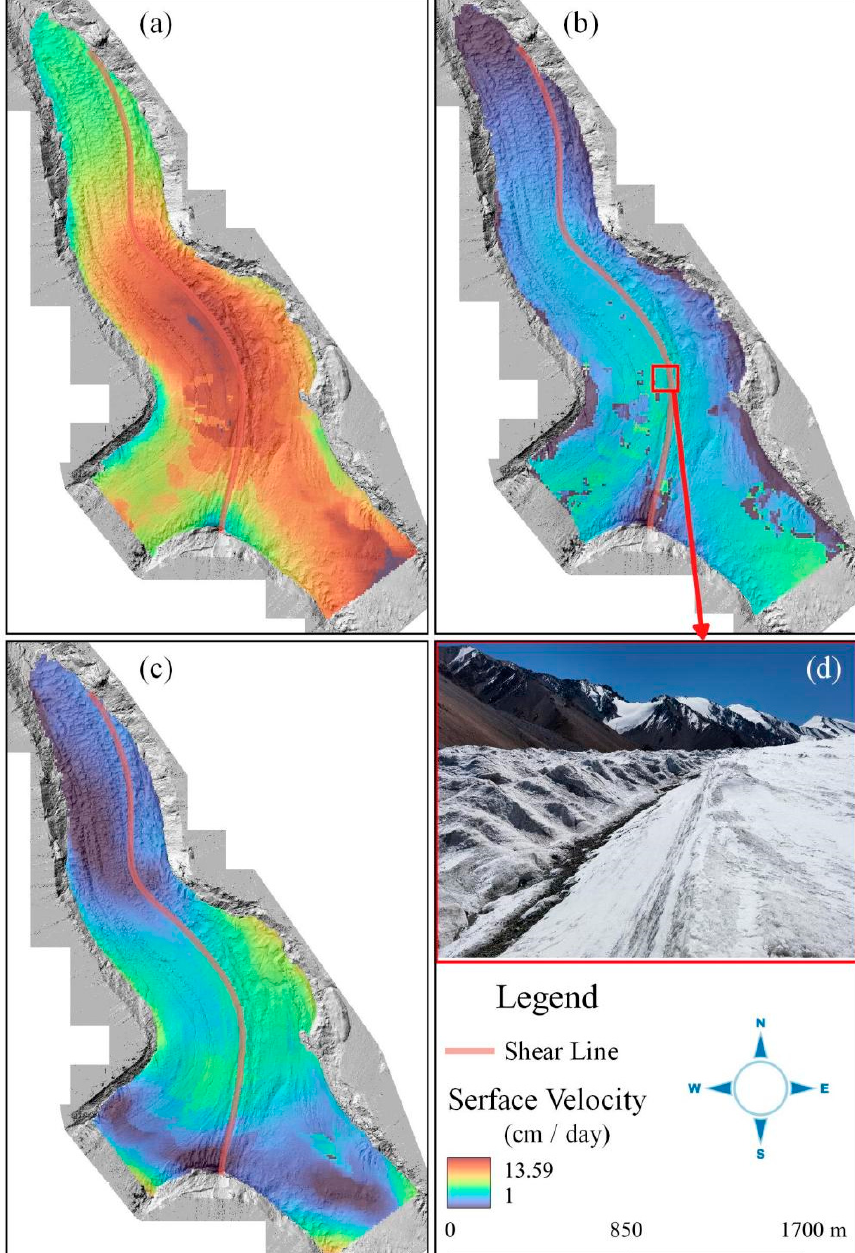
Figure 6. Glacier surface velocity extracted by hillshade images. ( a ) surface velocity on 4 June 2021–22 July 2021; ( b ) surface velocity on 16 July 2019–22 July 2021; ( c ) surface velocity on 22 July 2021–6 September 2021; ( d ) shear line at the confluence region.